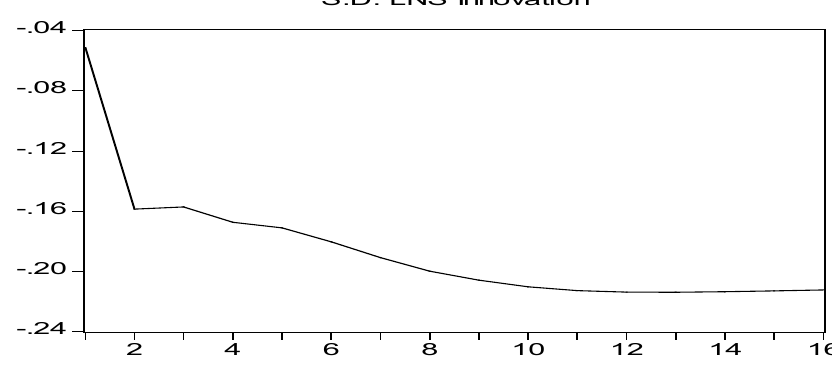
FIGURE 1: Impulse responses to exchange rate shocks: The exchange rate pass-through Source: